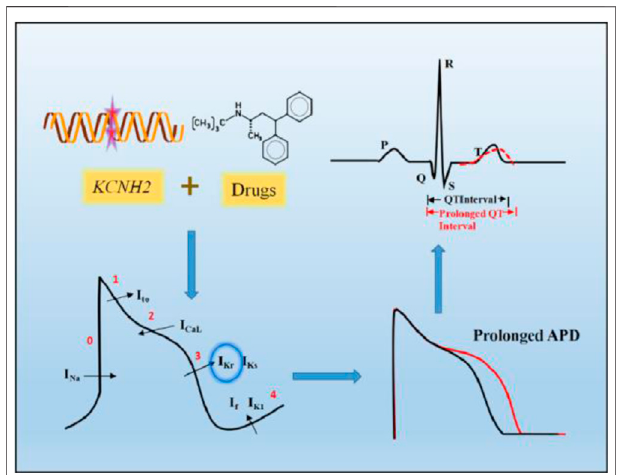
FIGURE 1 | Prolonged QT interval on ECG caused by hERG channel dysfunction. KCNH2 gene mutations and drugs targeting hERG channel can partially or completely reduce I Kr , which mainly function in the third phase of cardiac action potentials, resulting in prolonged action potentialduration (APD), shown on the ECG as a prolonged QT